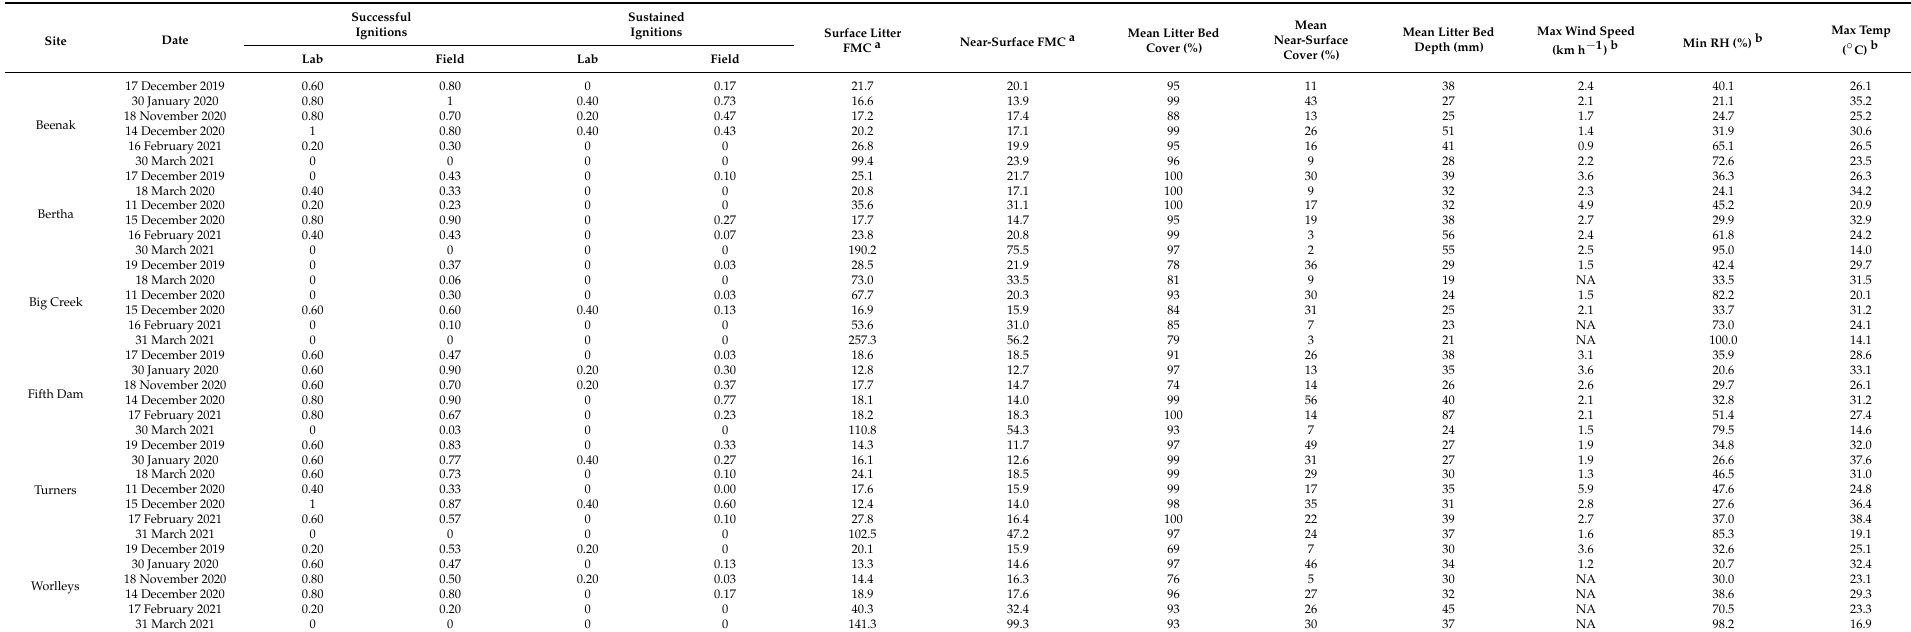
Table A3. Summary of ignition results, fuel moisture content (FMC), fuel structure data and weather recorded during the ignition